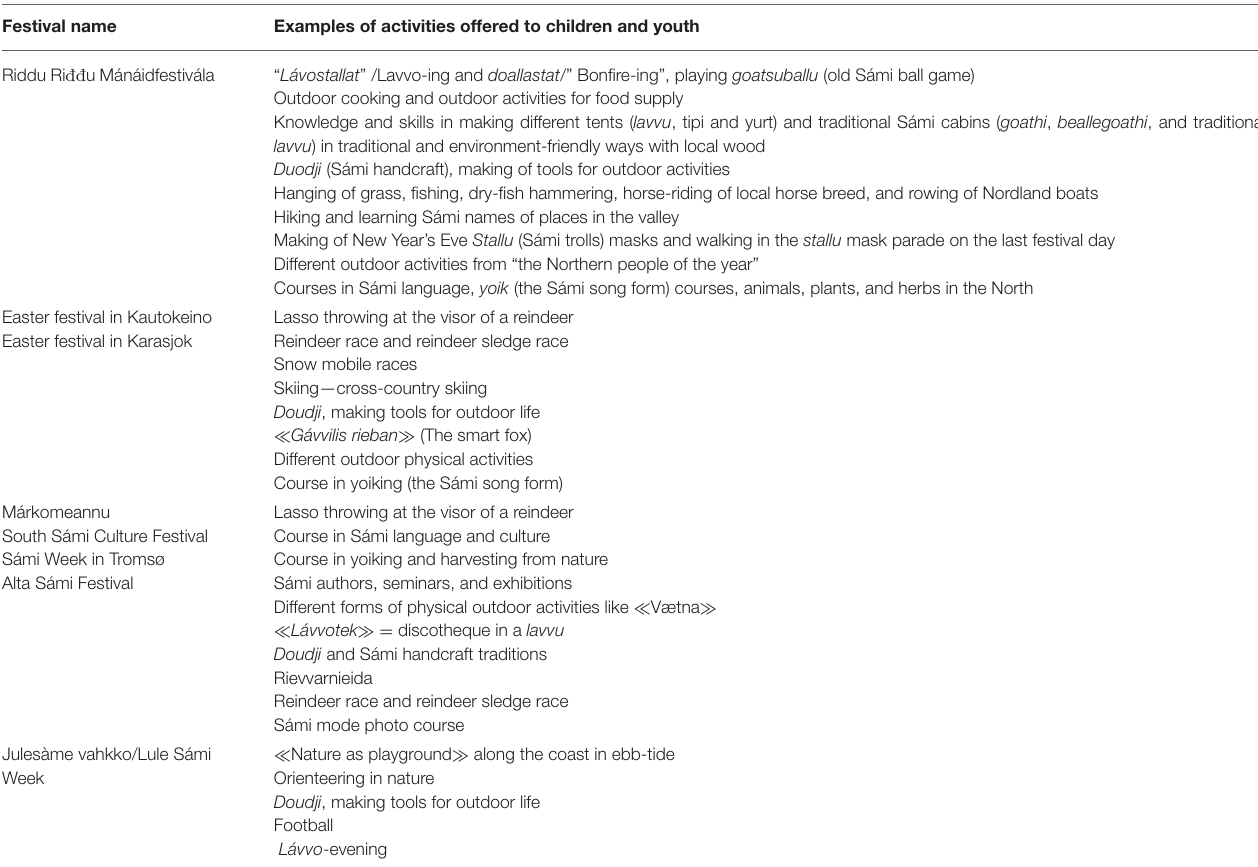
TABLE 2 | Activities offered to children and youth at eight Sámi festivals in Norway. Festival